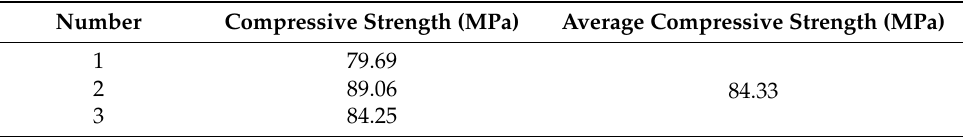
Table 2. Compressive strength of concrete.